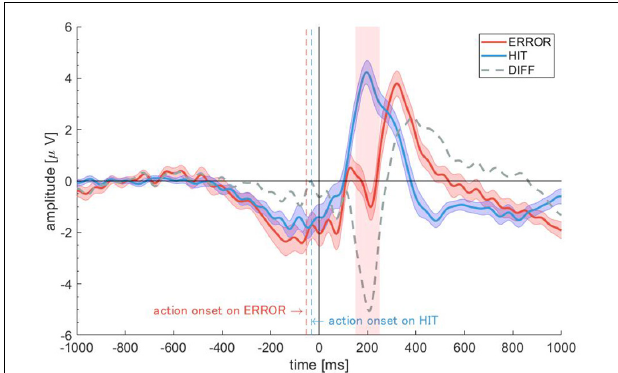
FIGURE 5 | Grand averaged event-related potentials (ERPs) for the ERROR and HIT events. The shades around the waveforms indicate the standard errors among the